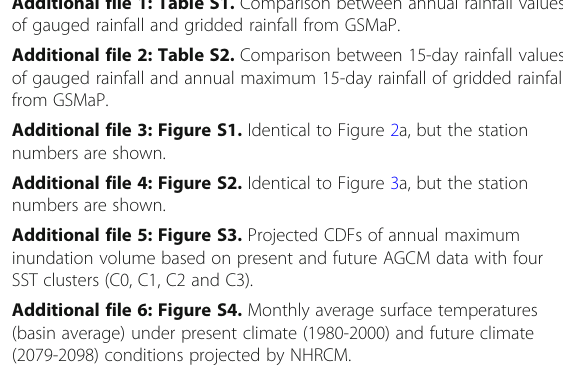
Additional file 3: Figure S1. Identical to Figure 2a, but the station numbers are shown. Additional file 4: Figure S2. Identical to Figure 3a, but the station numbers are shown. Additional file 5: Figure S3. Projected CDFs of annual maximum inundation volume based on present and future AGCM data with four SST clusters (C0, C1, C2 and